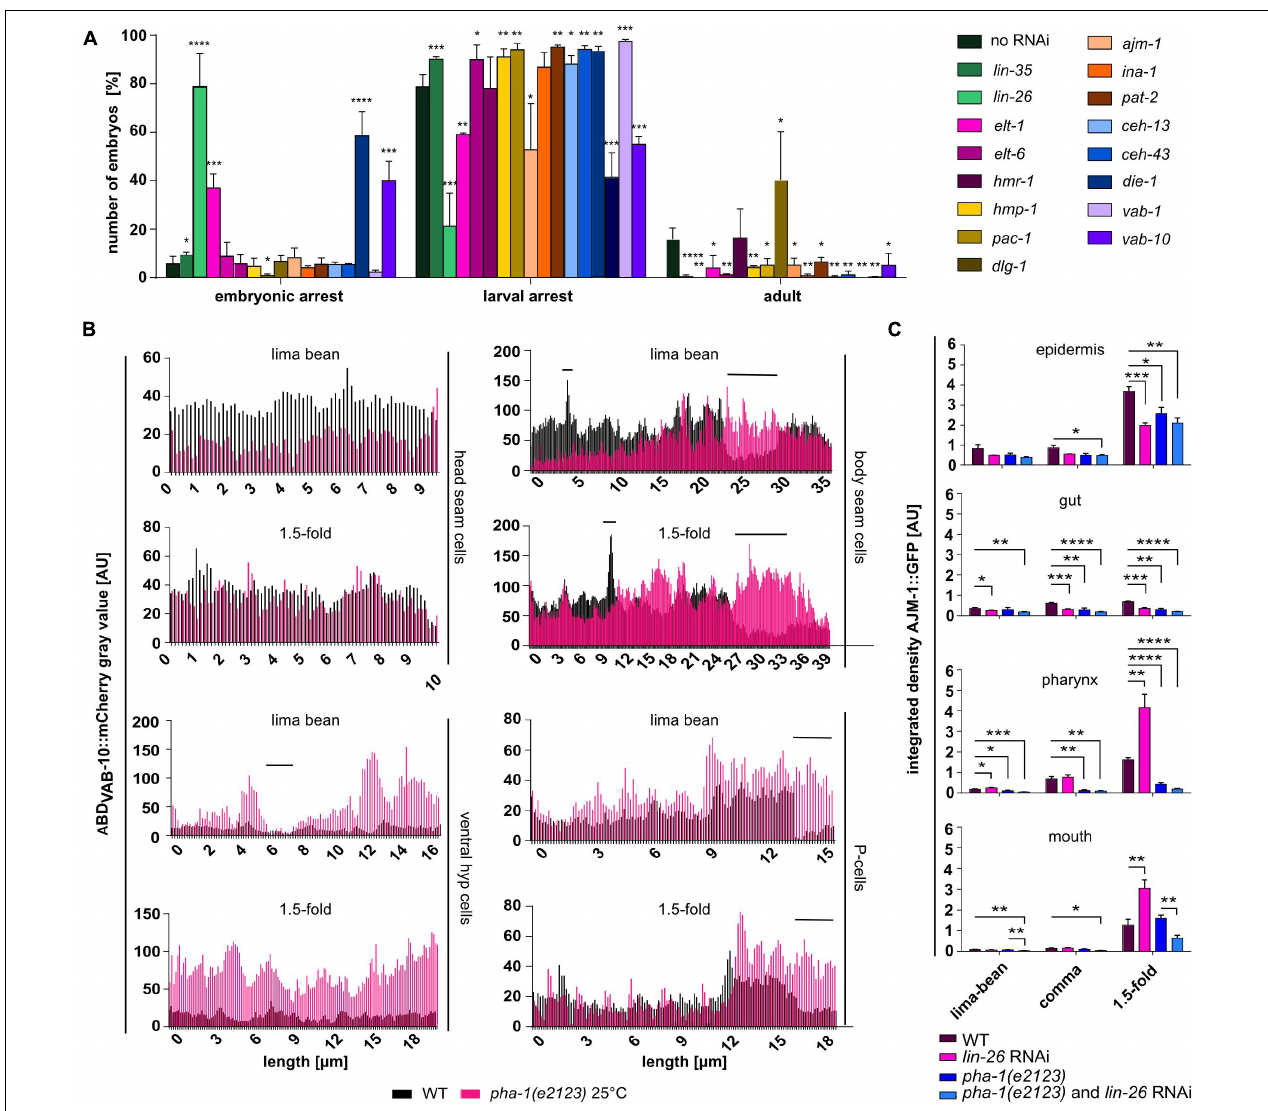
FIGURE 3 | Simultaneous downregulation of PHA-1 and epidermal differentiation- and morphogenesis factors changes viability of C. elegans embryos and larvae. (A) Viability assay of pha-1(e2123) mutants maintained at threshold temperature (19 ◦ C) with or without feeding RNAi for epidermal differentiation- or morphogenesis factors. Progeny was scored for embryonic arrest, larval arrest, or full development (adult) (data with SEM, n = 3 each; exceptions: no RNAi – n = 5; dlg-1 RNAi – n = 9). (B) P lin-26 ::ABD VAB - 10 ::mCherry expression in head seam cells, body seam cells, ventral hypodermis, and P-cells. Shown are signal intensities of representative WT and pha-1(e2123) embryos for lima-bean and 1.5-fold stage. (C) Quantification of signal intensities of AJM-1::GFP in different epithelia (epidermis, gut, pharynx, and mouth) of WT and pha-1(e2123) embryos with or without lin-26 feeding RNAi maintained either at the non-permissive temperature of 25 ◦ C [ pha-1(e2123) and pha-1 (e2123) / lin-26 RNAi] or at the threshold temperature of 19 ◦ C (WT lin-26 RNAi) (with SEM, n ≥ 4). Signals were measured during lima-bean, comma, and 1.5-fold stage. T-test: * p < 0.05; ** p < 0.01; *** p < 0.001; and **** p <